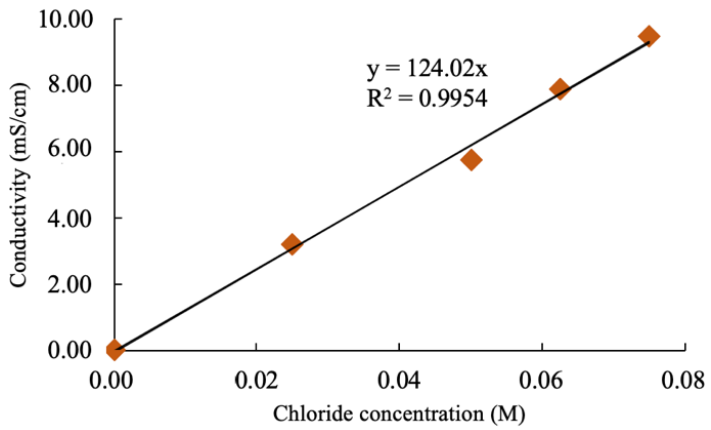
Figure 5. Adjustment for determining chloride concentration based on water